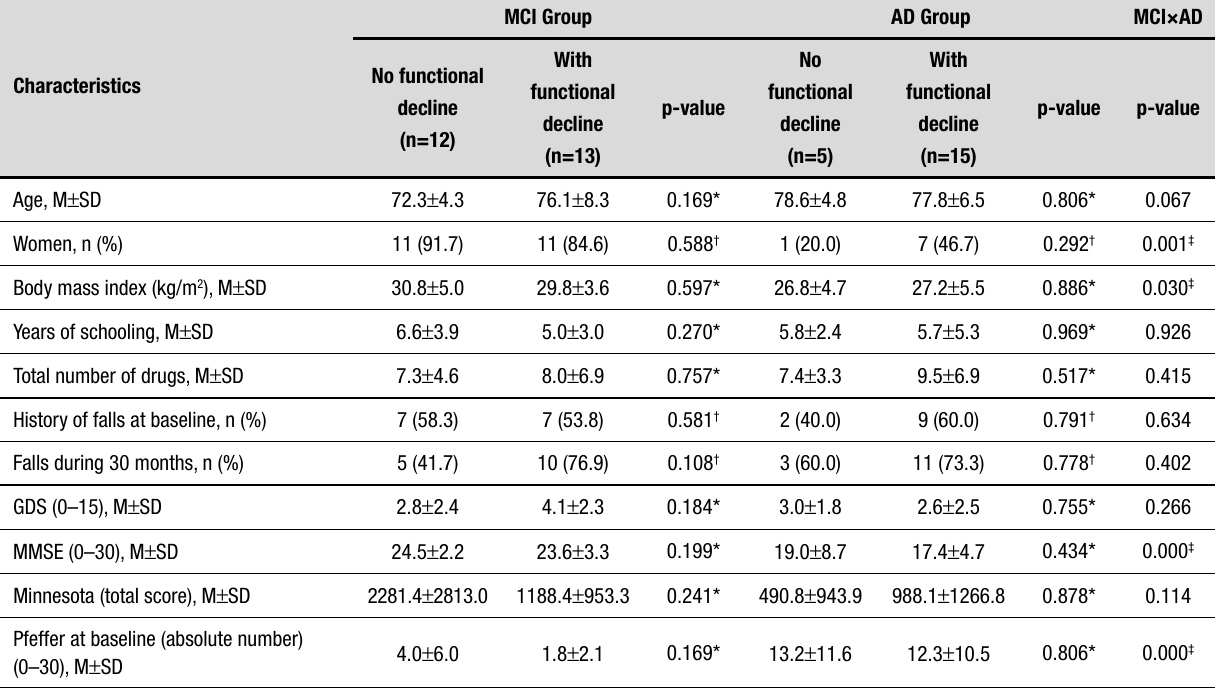
Table 1. Sociodemographic and clinical characteristics of sample at the baseline.